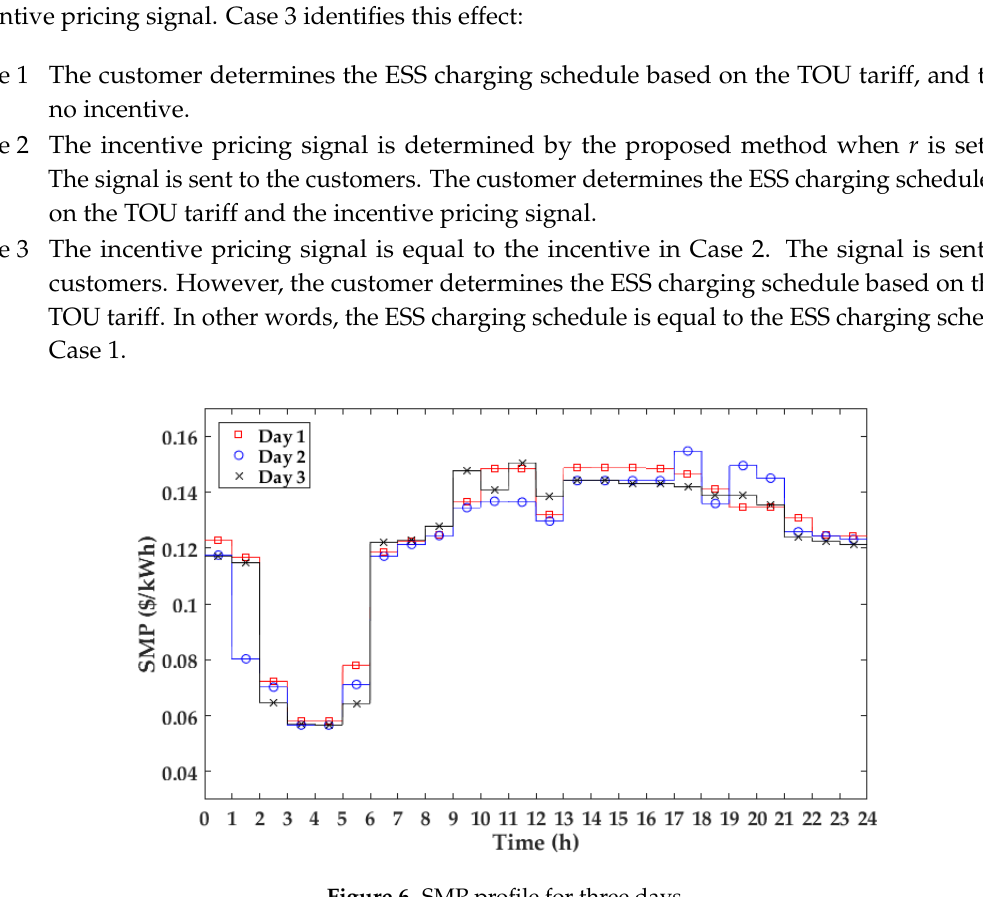
Figure 7. Load demand profile.